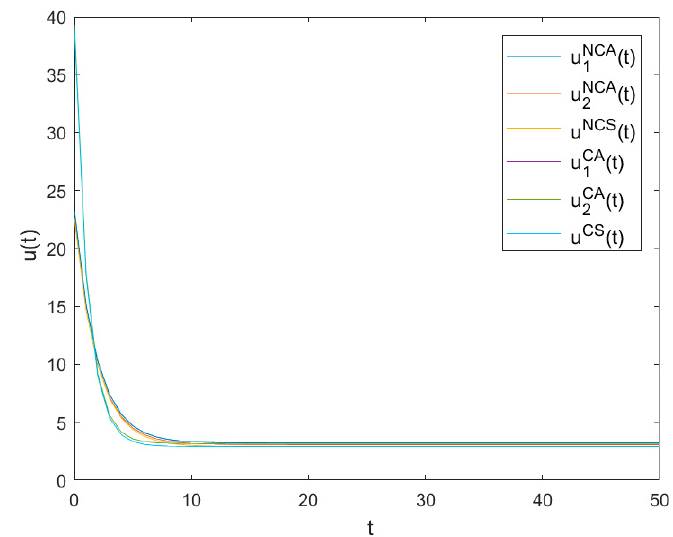
Figure 3. Evolutions of the optimal pollution abatement levels.